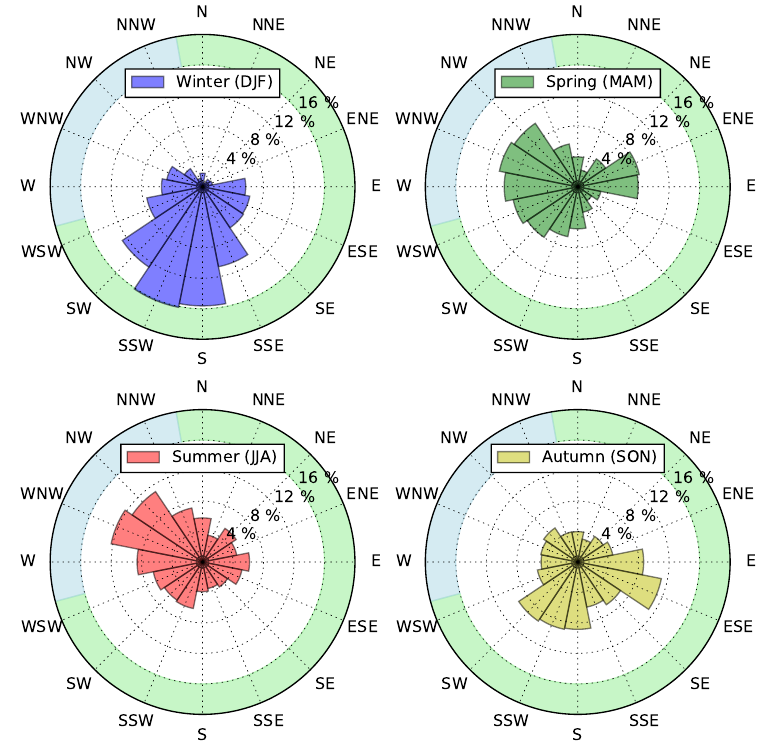
Figure 3. Seasonal wind direction distribution for Neuwerk (data from 4 July 2013 to 27 June 2016). The colored sectors show directions with wind from the coast (green) and from the open North Sea (blue).